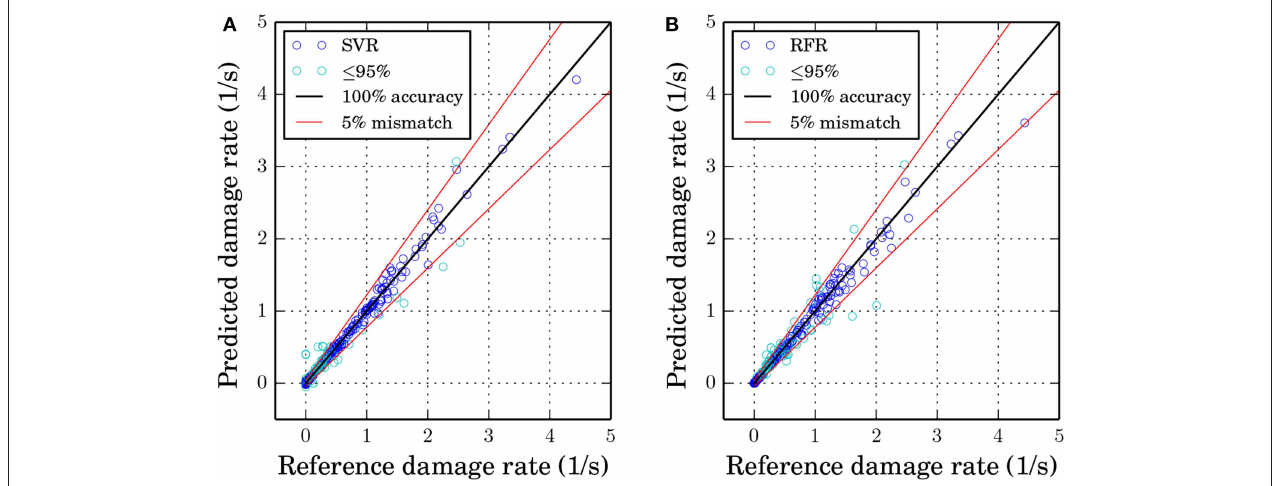
5 % mismatch border (red line) of the R 2 score and ±